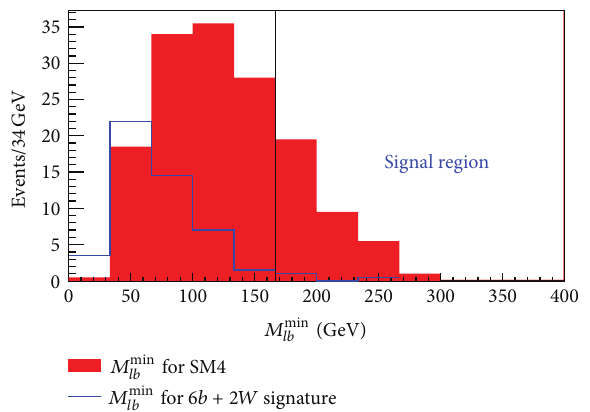
= 𝑚(𝑙 ] 𝑏) = 𝑚(𝑞𝑞𝑏) —the fit = gen 󸀠 → 2𝑊+6𝑏 𝑇 ). See also